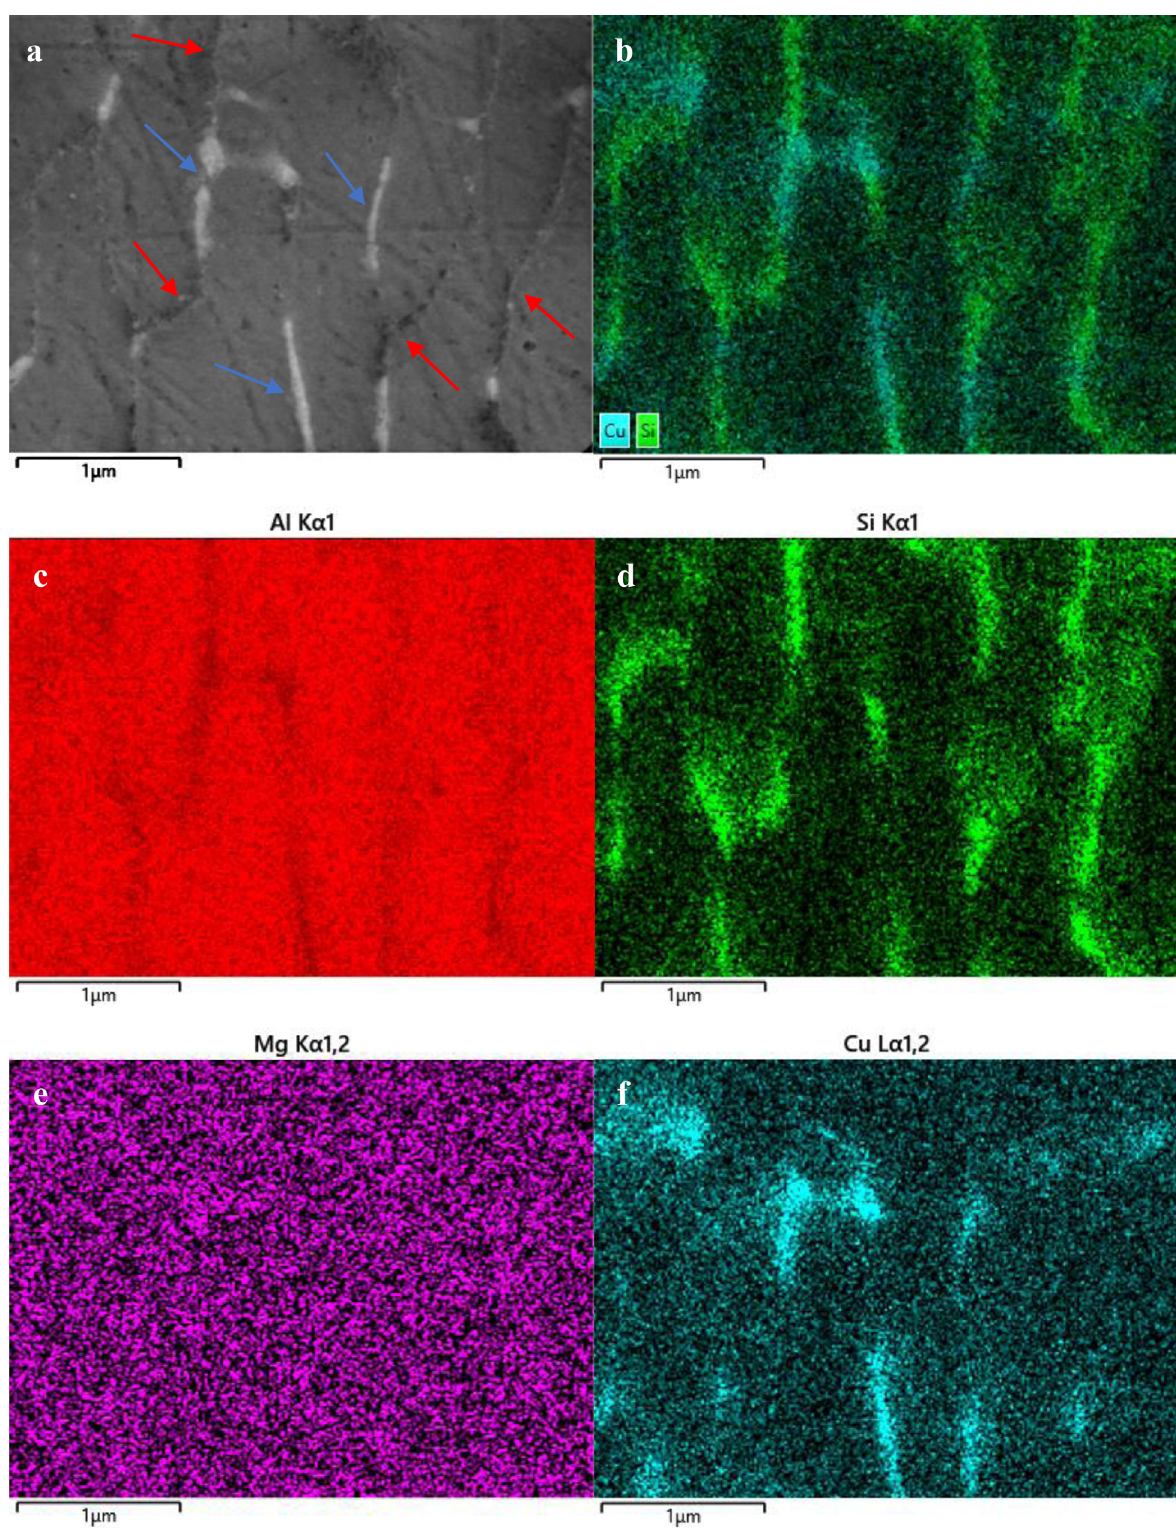
Fig. 3. AlSi5Cu3Mg alloy (cid:1) Analysis of the eutectic (cid:1) as built. (a) FEG-SEM examination: electronic image. (b) to (f): EDS analyses (mapping of chemical